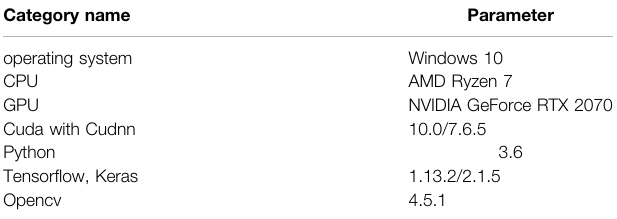
TABLE 3 | Parameters related to the experimental environment.